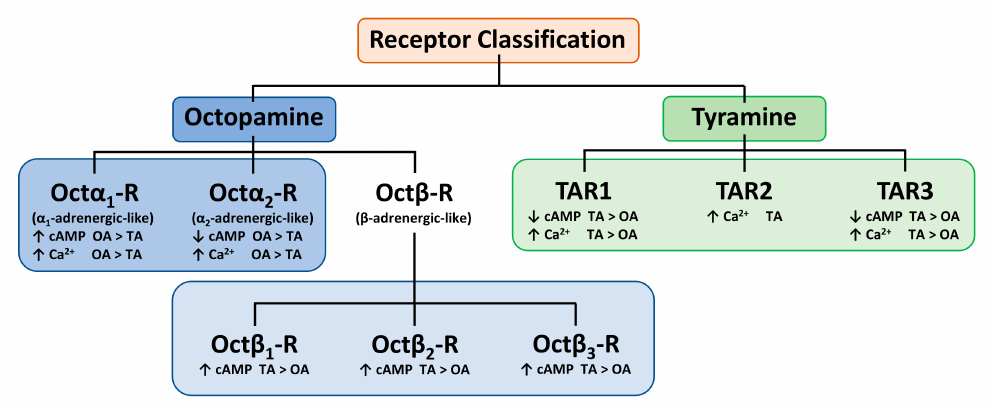
Figure 2. Revised scheme, based on Hana and Lange, describing the tyramine (TA)/octopamine (OA) receptors classification based on their sensitivity to ligands and their downstream effects